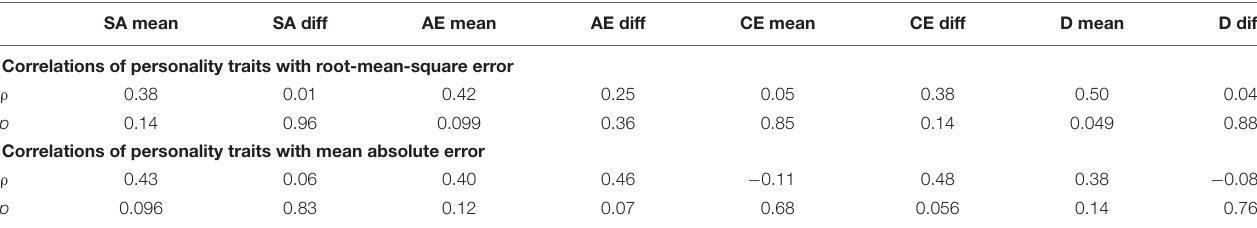
TABLE 5 | Correlations between engagement estimation errors and the means and differences in four personality traits in dyad-non-specific estimation.